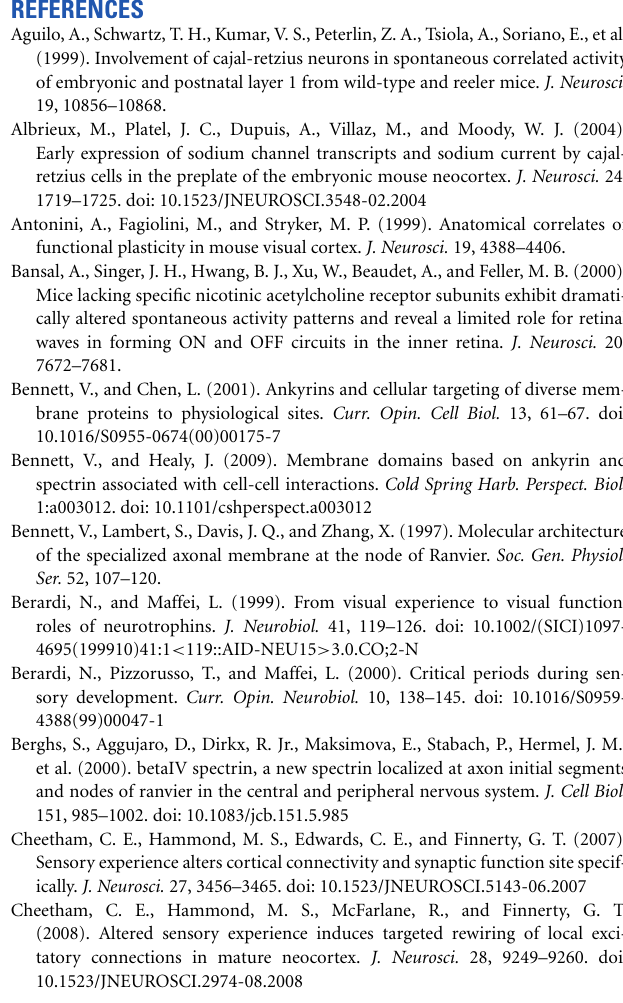
Figure S1 | Specificity analysis for two commercially available ankG antibodies, polyclonal rabbit anti-ankG and monoclonal mouse anti-ankG (see Table 2) in postnatal visual cortex. (A) Rb anti-AnkG (green) and ms anti-ankG (red) in layer II/III neurons in a P15 animal. Signal overlap is indicated by yellow staining. (B) Fluorescence intensity profile for both antibodies for the representative AIS from (A) indicated by an arrow. Graph shows signal overlap for both antibodies. (C) Same as (A) , but in P28 visual cortex. (D) Same as (B) , but for the AIS indicated by an arrow in (C) . (E) Same as (A) , but in > P180 visual cortex. (F) Same as (B) , but for the AIS indicated by an arrow in (E) . Scale bars (A,C,E) = 10 μ m. Figure S2 | Specificity analysis for two commercially available antibodies, a polyclonal rabbit anti- β IV spectrin and a monoclonal mouse anti-ankG (see Table 2) to show that the ms ankG antibody specifically stains AIS in postnatal tissue. (A) Ms anti-AnkG (green) and rb anti- β IV spectrin (red) in layer II/III neurons in a P15 animal. Signal overlap is indicated by yellow staining. (B) Fluorescence intensity profile for both antibodies for the representative AIS from (A) indicated by an arrow. Graph shows signal overlap for both antibodies. (C) Same as (A) , but in P28 visual cortex. (D) Same as (B) , but for the AIS indicated by an arrow in (C) . (E) Same as (A) , but in > P180 visual cortex. (F) Same as (B) , but for the AIS indicated by an arrow in (E) . Scale bars (A,C,E) = 10 μ